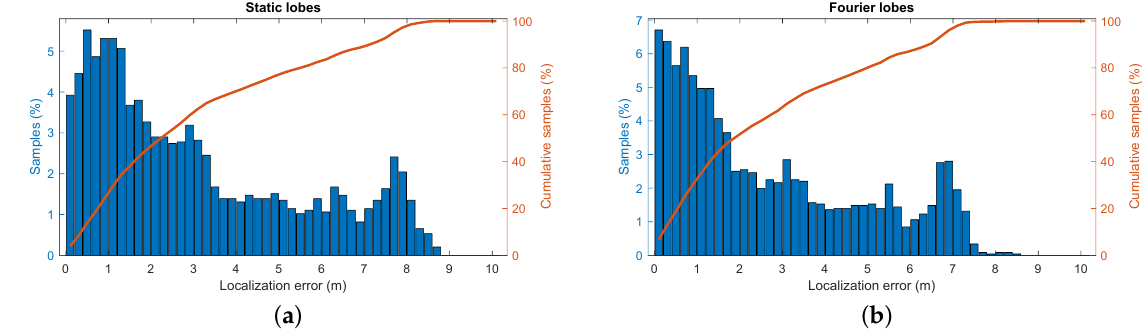
Figure 10. Simultaneous localization and mapping metrics for the different ERTFs. ( a ) The distribution of the positional error for the trajectory generated from the static ERTF compared to the ground truth. ( b ) The distribution of the positional error for the trajectory generated from the varying ERTF compared to the ground